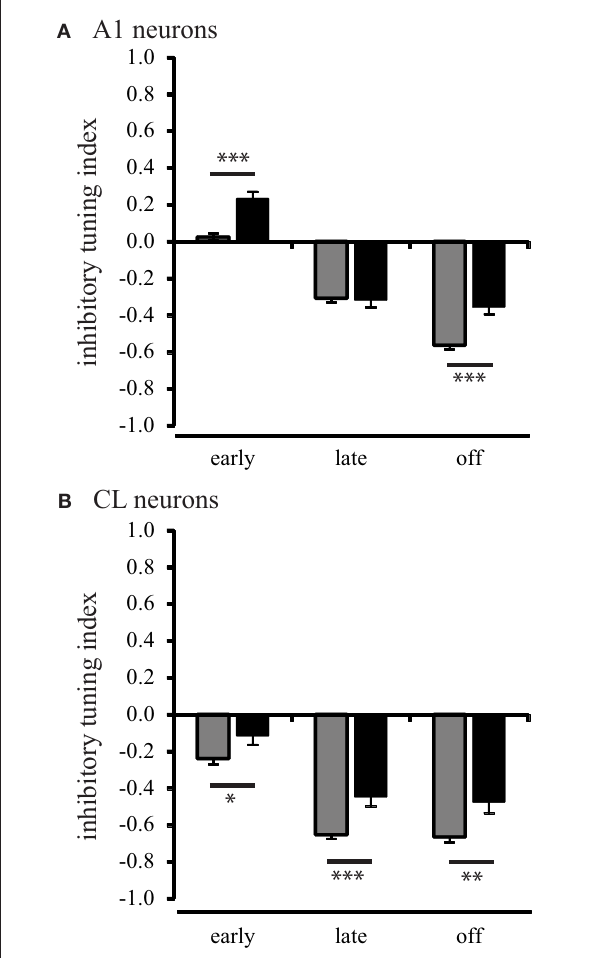
FIGURE 6 | Population inhibitory tuning index comparison between young and aged animals. The inhibitory index showed a significant difference between young and aged A1 neurons during the early and off response periods (Panel A ). Panel (B) shows that the strength of inhibition or suppressed response is greater in young animals compared to aged animals for CL neurons ( ∗ p < 0 . 05; ∗∗ p < 0 . 01; ∗∗∗ p < 0 . 001).